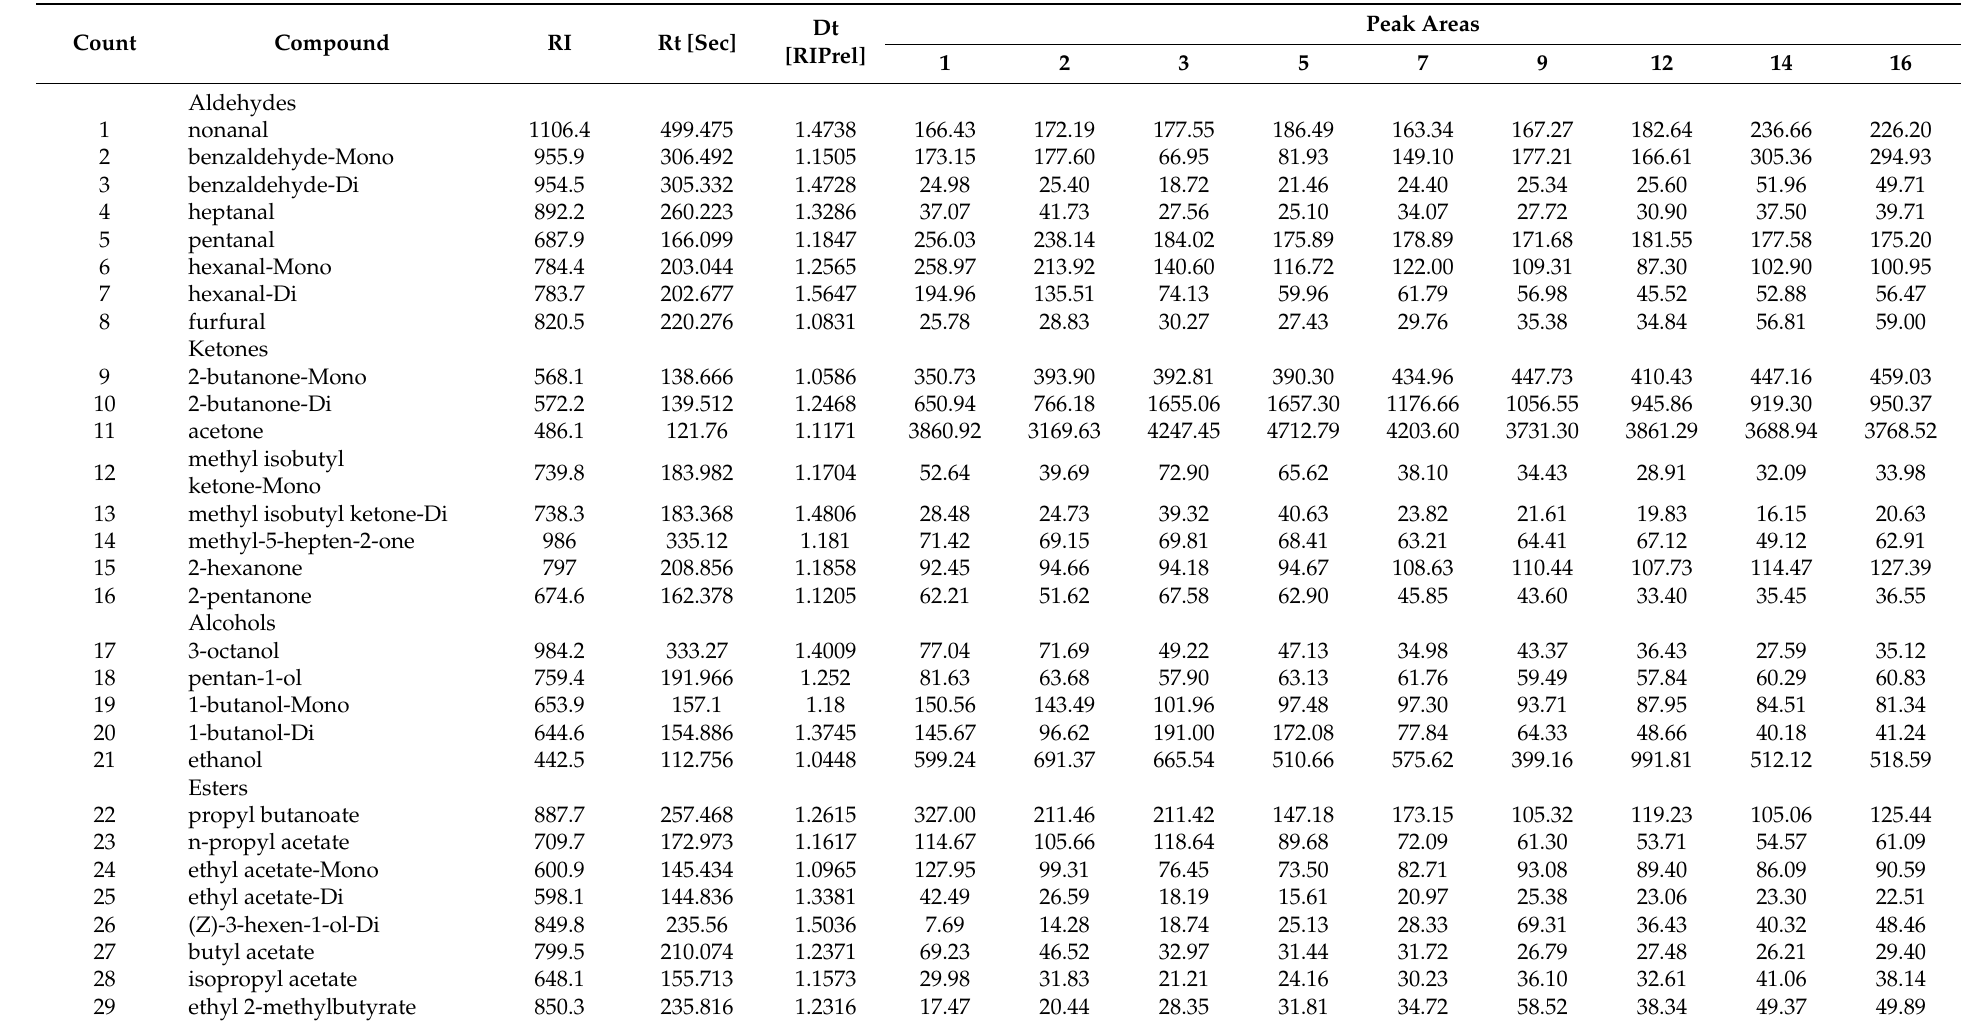
Table 4. Volatile components found in honey